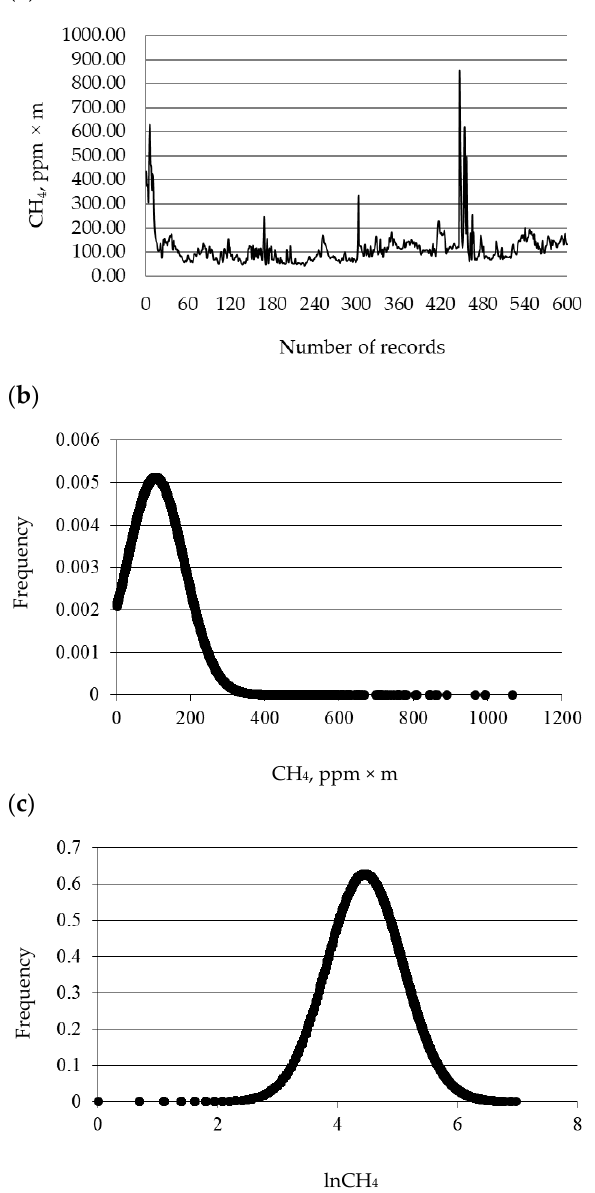
Figure 1. ( a ) Methanogram plot representing records (n = 600) of CH 4 emissions (ppm × m) collected during one measurement of a heifer, ( b ) distribution of CH 4 emissions (n = 27,000) expressed as ppm × m, and ( c ) distribution of CH 4 emissions (n = 27,000) expressed as log e -transformed data (lnCH 4 ).